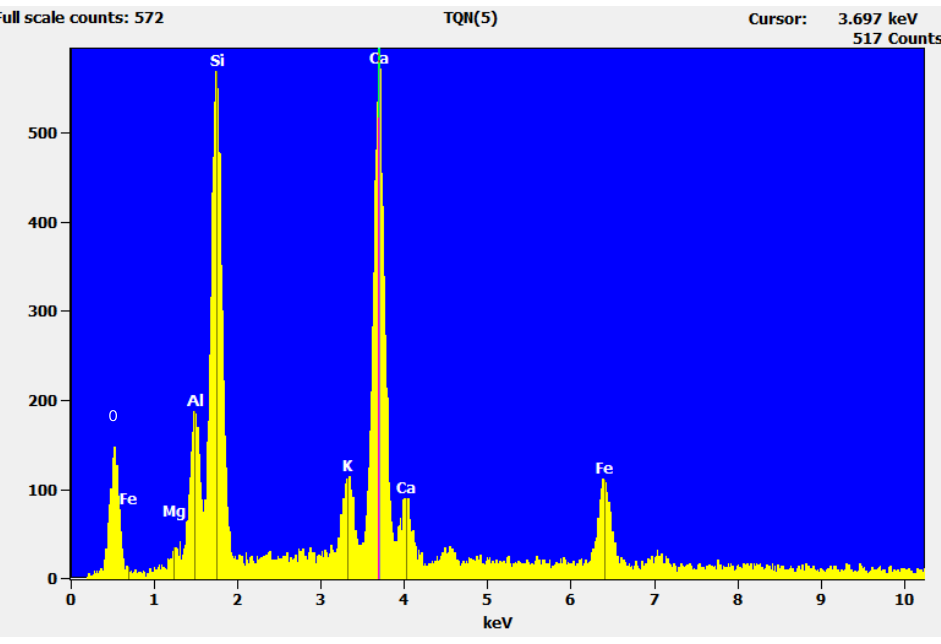
Figure 13. EDS spectrum of TQ0.